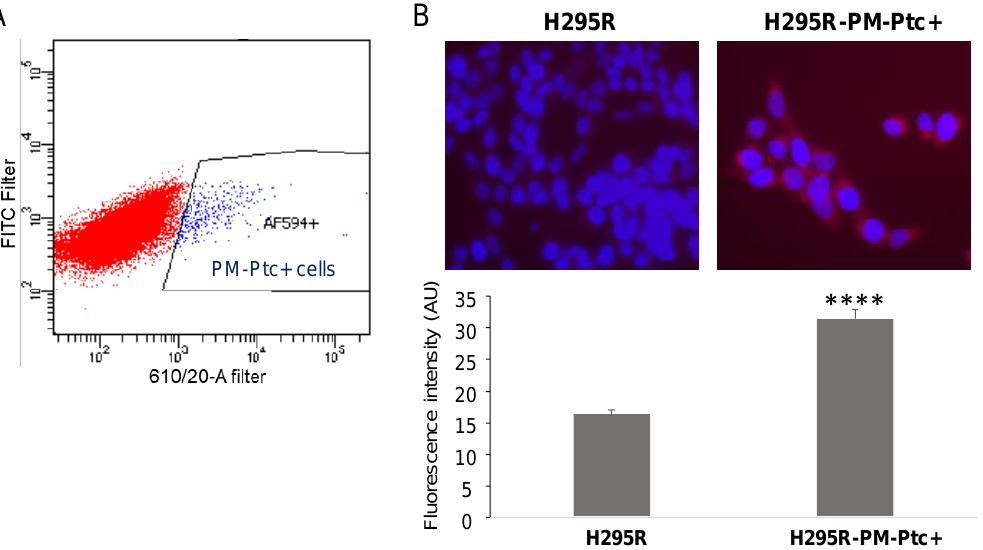
Figure 1. A small population of ACC cells H295R overexpresses Ptch1 at the plasma membrane . ( A ) H295R were labeled with an anti-Ptch1 antibody directed against the extracellular loop and cells presenting Ptch1 at their plasma membrane (H295R-PM-Ptc+ AF594+ cells) were sorted. AF594+ in blue represents the percentage of cells with Ptch1 at the cell surface (H295R-PM-Ptc+ cells). ( B ) Surface labeling of Ptch1 using anti-Ptch1 antibody directed against the extracellular loop of Ptch1 (Alexa 594 in red) on nonpermeabilized parental H295R and H295R-PM-Ptc+ cells. Nuclei were stained with DAPI (in blue). The histogram represents the mean ± SEM of Alexa 594 fluorescence intensity per cell (****: p -value < 0.00005 ( p -value = 2 × 10 −3 6 )).